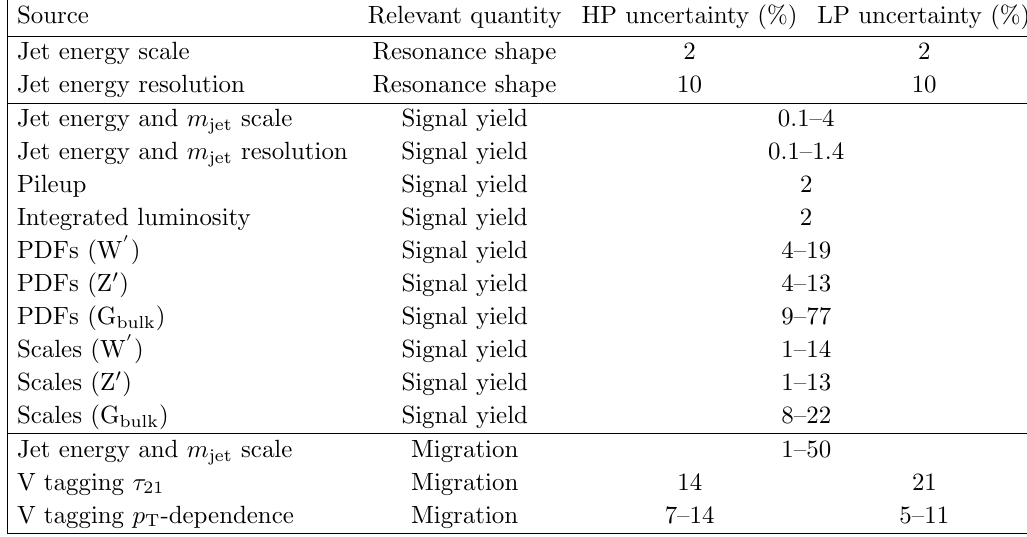
Table 7 . Summary of the systematic uncertainties in the contribution from signal in the dijet anal- ysis and their impact on the event yield in the signal region and on the reconstructed distribution in m VV (mean and width). The last three uncertainties result in migrations between event categories, but do not a(cid:11)ect the overall signal